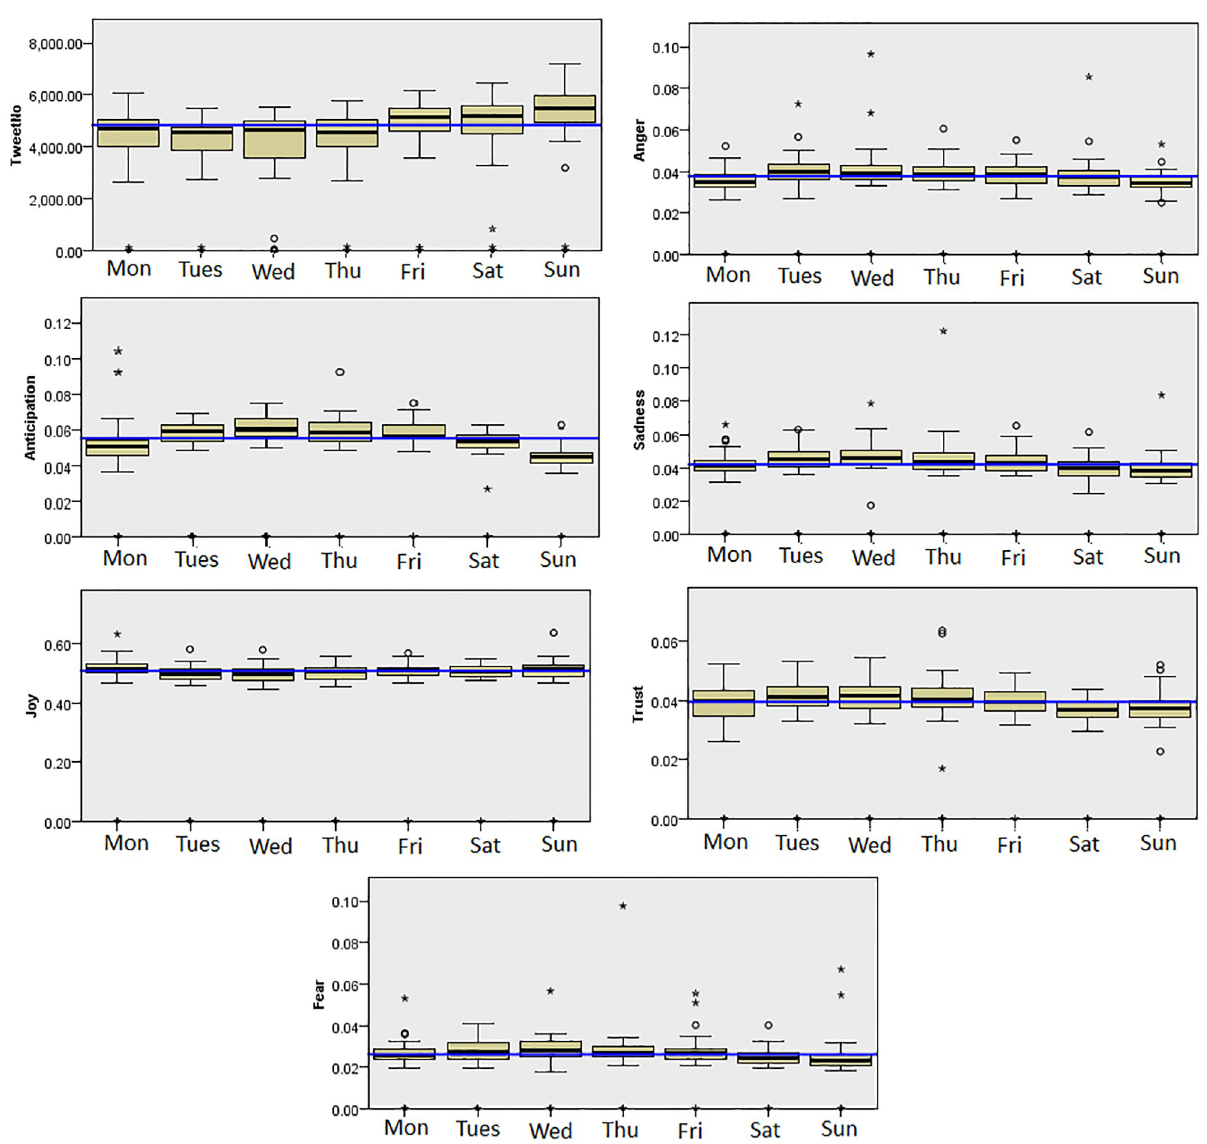
Fig 6. The emotions displayed on different days of the week in